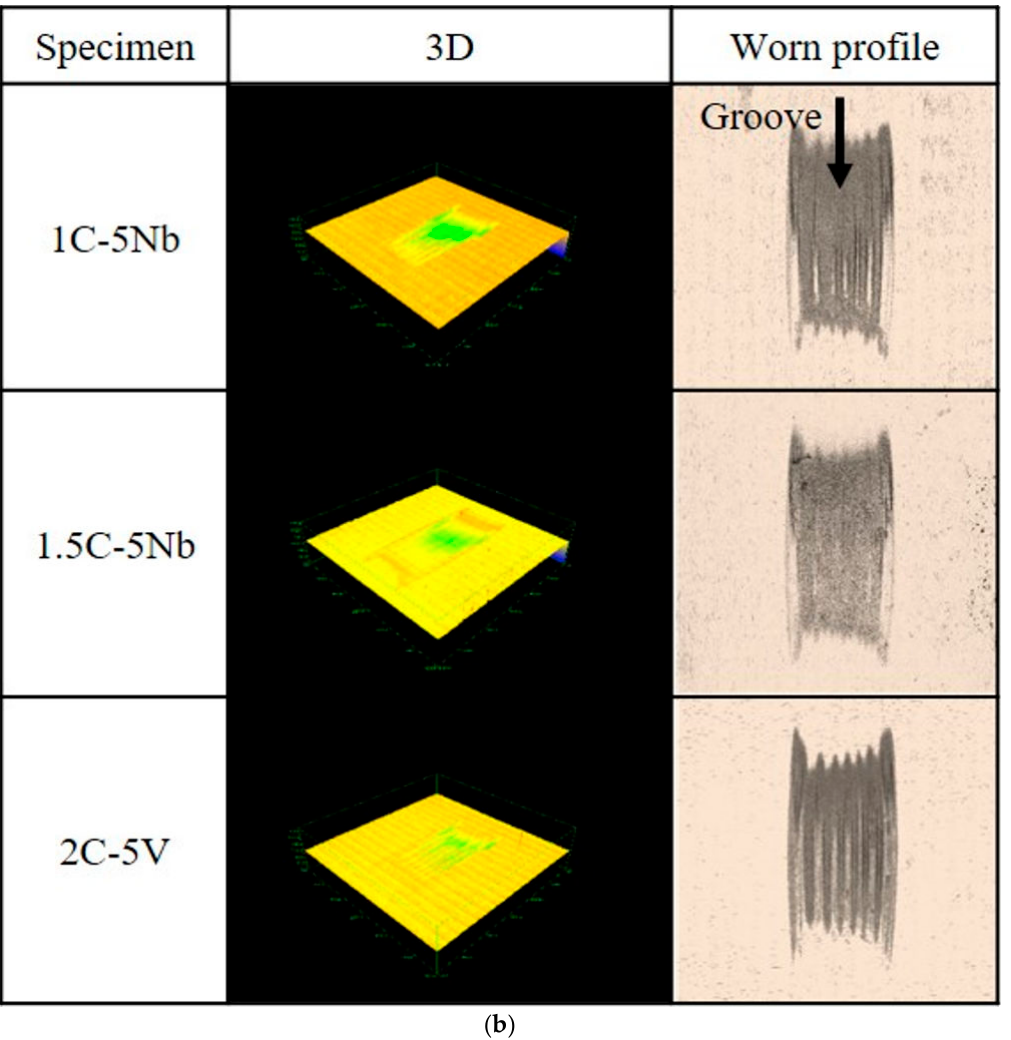
Figure 9. Investigation of the worn surface of each alloy using laser technology. ( a ) The 3D and worn profile of 5V-5Cr-5Mo-5W-5Co-Fe. ( b ) The 3D and worn profile of 5Nb-5Cr-5Mo-5W-5Co-Fe.